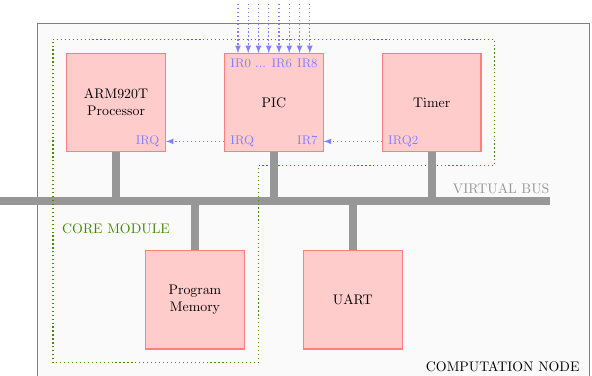
Figure 3: Architecture of a computation